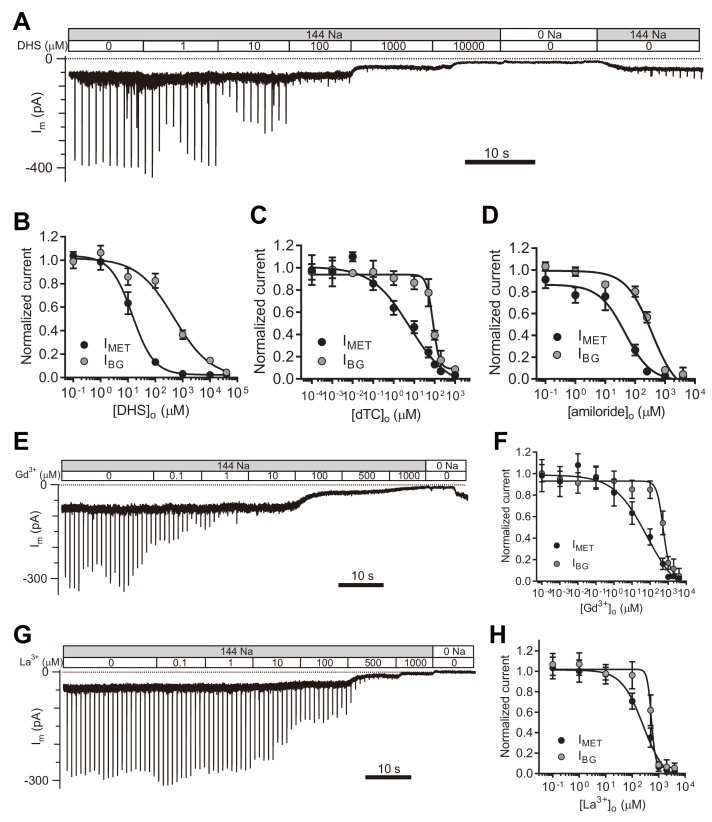
TMC1-mediated leak conductance is antagonized by MET channel blockers.(A and B) Representative trace (A) and statistical curve (B) of Im inhibition by DHS. A 10 Hz train of 800 nm step deflection was applied to the hair bundle by a glass probe to induce MET currents. IMET and IBG were calculated and plotted against the DHS concentration. As fitted, the IC50 of DHS was 15 μM for the MET channels and 487 μM for the leak conductance. Cell numbers, 7–11. Hill slope: IMET, −1.10; IBG, −0.65. (C and D) Statistical dose curve of Im with graded concentrations of d-tubocurarine (dTC) (C) and amiloride (D). dTC IC50: IMET, 6 μM; IBG, 82 μM. dTC Hill slope: IMET, −0.47; IBG, −2.80. dTC cell numbers, 5–15. Amiloride IC50: IMET, 46 μM; IBG, 365 μM. Amiloride Hill slope: IMET, −1.36; IBG, −1.67. Amiloride cell numbers, 7–16. (E and F) Dosage effect of Gd3+. Example trace (E) and statistical curve (F) of Im in OHCs during perfusion with solutions containing graded concentrations of Gd3+. A train of 800 nm step deflection was applied to the hair bundle by a glass probe to induce MET currents. The MET and leak current amplitudes changed because of the channel sensitivity of Gd3+ and NMDG. IC50: IMET, 66 μM; IBG, 524 μM. Hill slope: IMET, −0.48; IBG, −2.49. Cell numbers, 7–16. (G and H) Dose effect of La3+. Example trace (G) and dosage curve (H) of Im with La3+ treatment. A train of 800 nm step deflection was applied to the hair bundle by a glass probe to induce MET currents. IC50: IMET, 259 μM; IBG, 531 μM. Hill slope: IMET, −1.06; IBG, −5.67. Cell numbers, 7–8. For space reasons, 144 NMDG is shown as 0 Na. The external solution contained 1.3 mM Ca2+. The holding potential was −70 mV. Data are presented as mean ± SEM.10.7554/eLife.47441.016Figure 5—source data 1.TMC1-mediated leak conductance is antagonized by MET channel blockers.